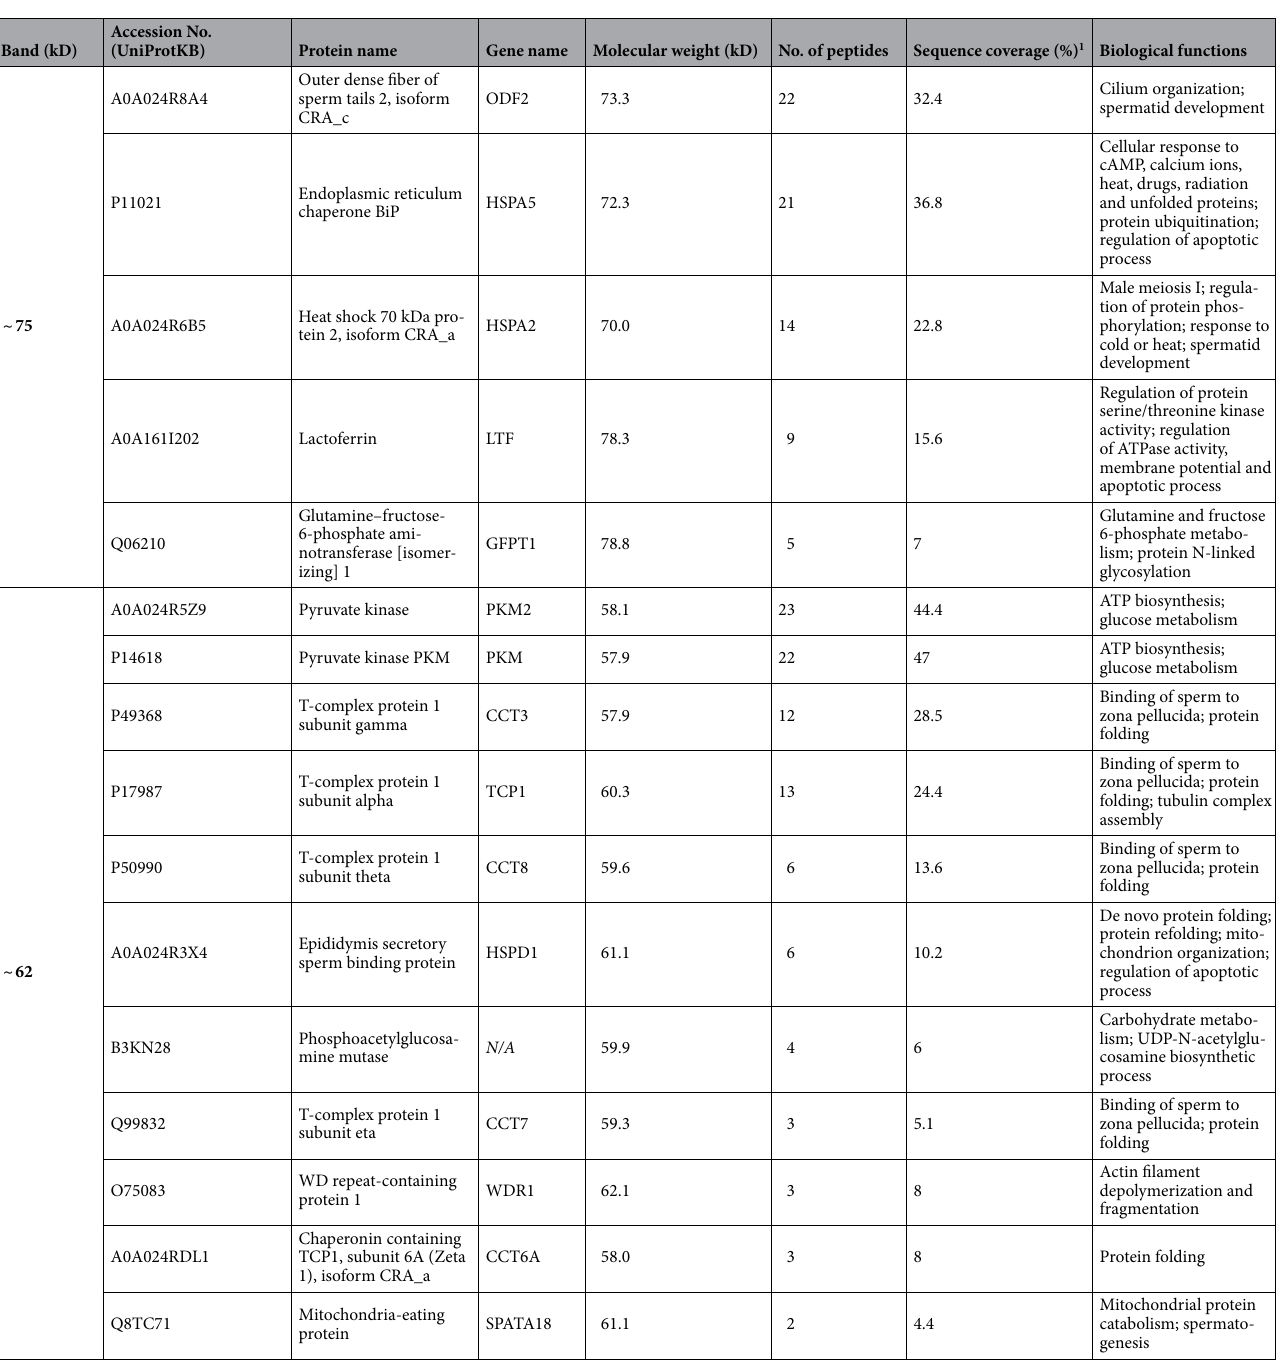
Table 1. List of proteins identified via HPLC-ESI-Q-TOF–MS/MS in human spermatozoa. 1 Percentage of the protein sequence covered by identified